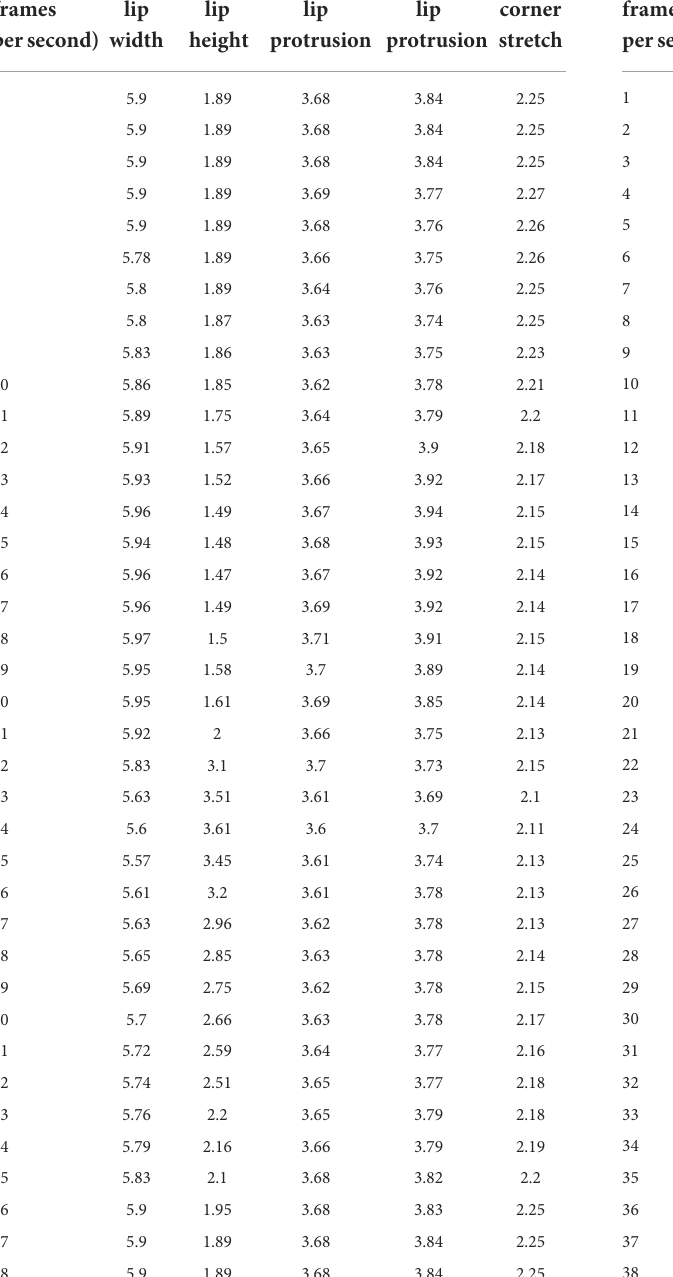
TABLE 4 The dynamic data value of each part of “ ”/ta/ in the Tibetan Xiahe dialect (unit: cm). Frame(25